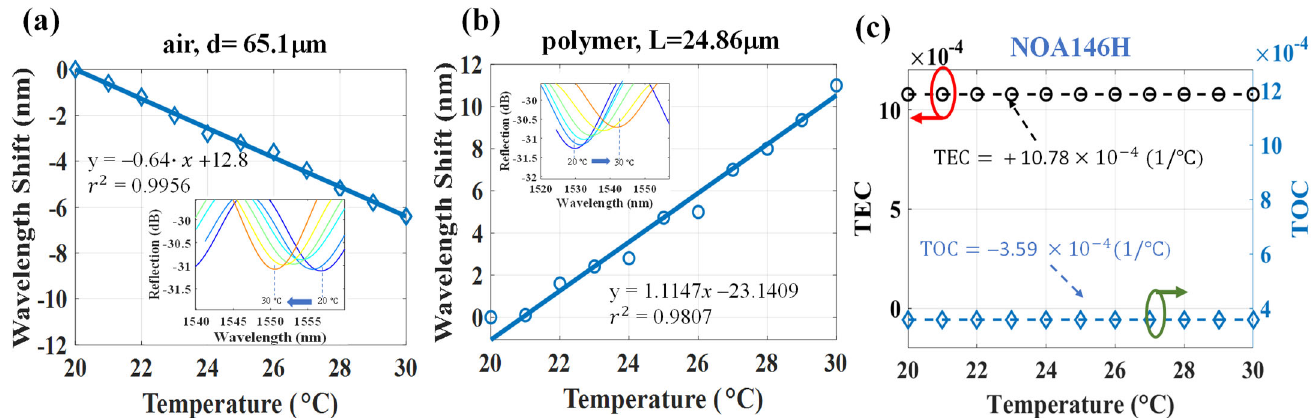
Figure 7. Wavelength shifts from 20 °C to 30 °C for the cavities of ( a ) air, ∆λ a , and ( b ) NOA146H ‐ polymer, ∆λ p ; ( c ) the measured TEC and TOC from the results of ( a , b ).